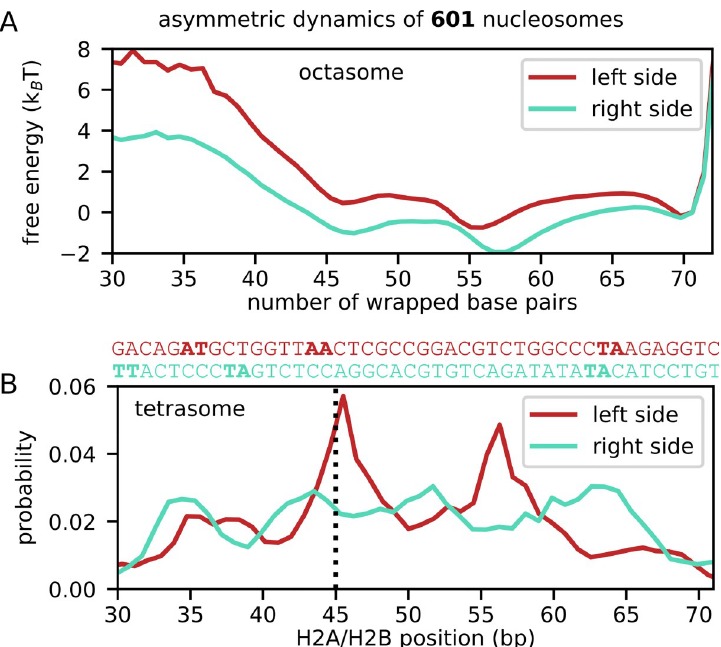
Fig 3. Asymmetric dynamics in 601 nucleosomes. (A) Free energy curves of DNA wrapping for the left (in red) and right (in blue) halves of assembled nucleosome at 400 mM. Only the structural ensemble corresponding to the state N, i.e., complete nucleosome, in the MSM (Fig 2) is used. The free energy at the complete wrapping of 70 bp is set to zero. (B) For the tetrasome states including T, T R and T L , we plot the probability of the positions of the unbound H2A/H2B dimers on the left (in red) and the right (in blue) sides of the 601 DNA. The DNA position corresponds to the base pair of the phosphate group that is closest to residue ARG29 on the H2A histone (as described in Methods). On the left side the dimer has a much higher probability to be localized at the same position as when bound to the H3/H4 tetramer (indicated by the black dotted line), facilitating successful assembly. On top of the graph, we align each side of the 601 sequence to the DNA position axis (left side in red, right side in